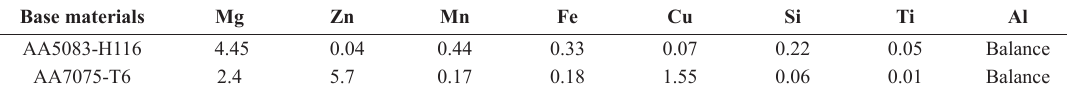
Table 1. Chemical composition of the base materials.